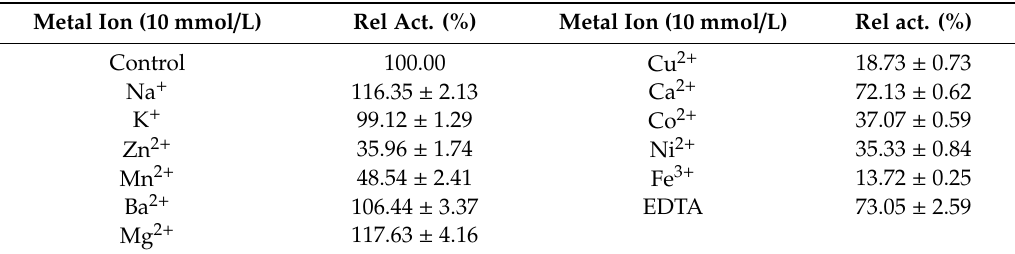
Table 1. The influences of metal ions and chemicals on the activity of the Xyl88.